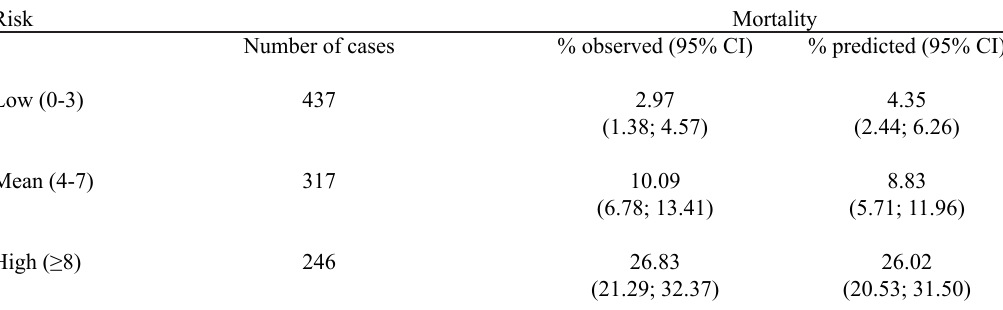
Table 1. InsCor calibration - Analysis by risk